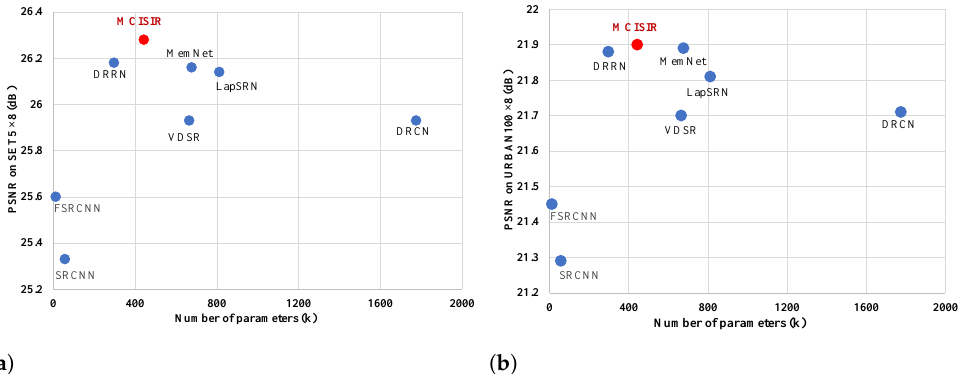
Figure 9. Performance comparisons in terms of PSNR versus network model parameters on SET5 ( a ) and URBAN100 test datasets with enlargement factor 8 × ( b ).